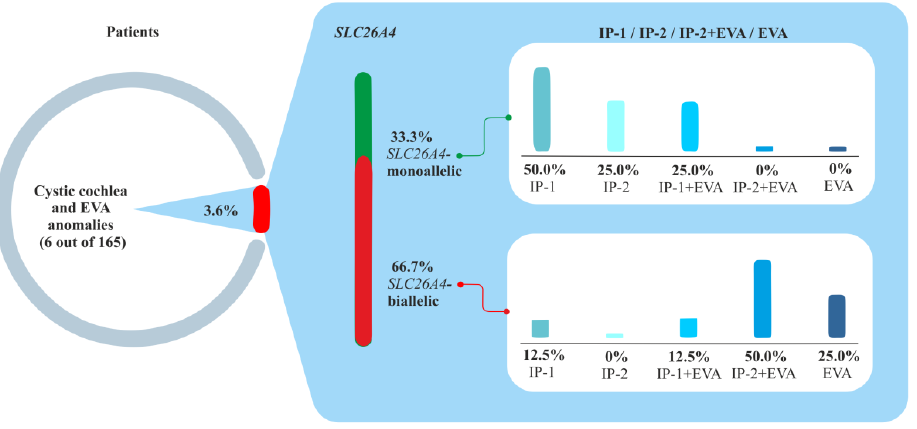
Figure 4. Morphology of the inner ear anomalies in biallelic SLC26A4 and monoallelic SLC26A4 patients. Note. IP-1, incomplete partition Type 1; IP-2, incomplete partition Type 2; EVA, enlargement of the vestibular aqueduct.